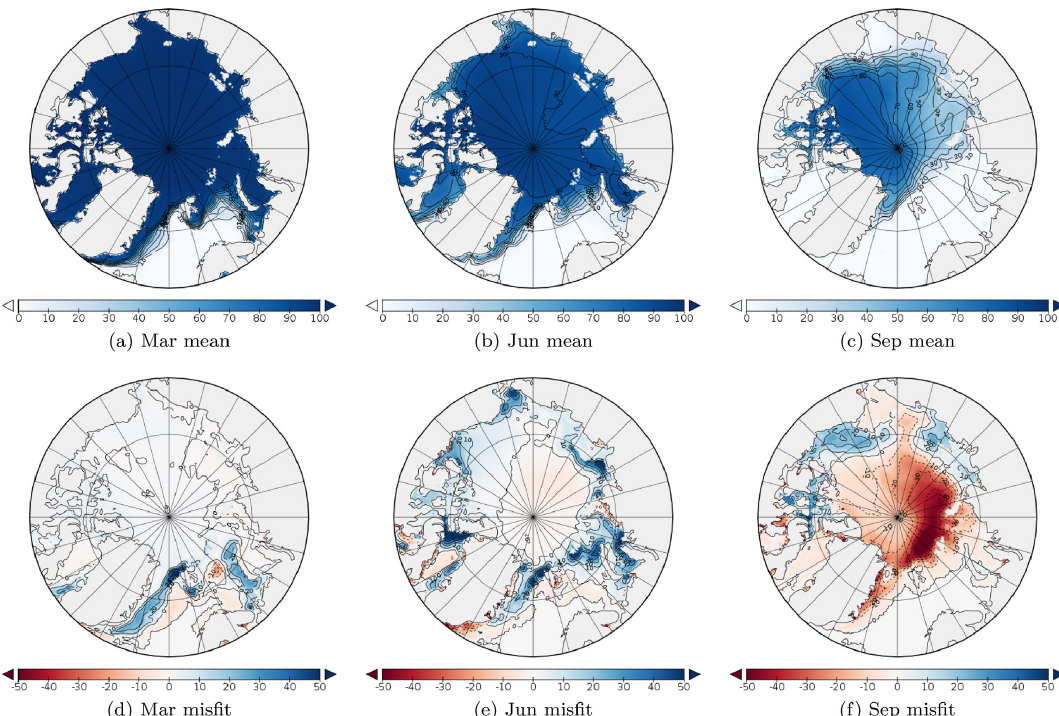
Figure 6. The long-term mean sea ice concentration (%) of the Arctic MPIOM for 1990 to 2008 for March, June and September ( a to c ) and the misfit to the OSI SAF sea ice concentration (panel d to f ). In panels (d) to (f) , shades of red indicate underestimation and shades of blue indicate overestimation of sea ice concentration in the